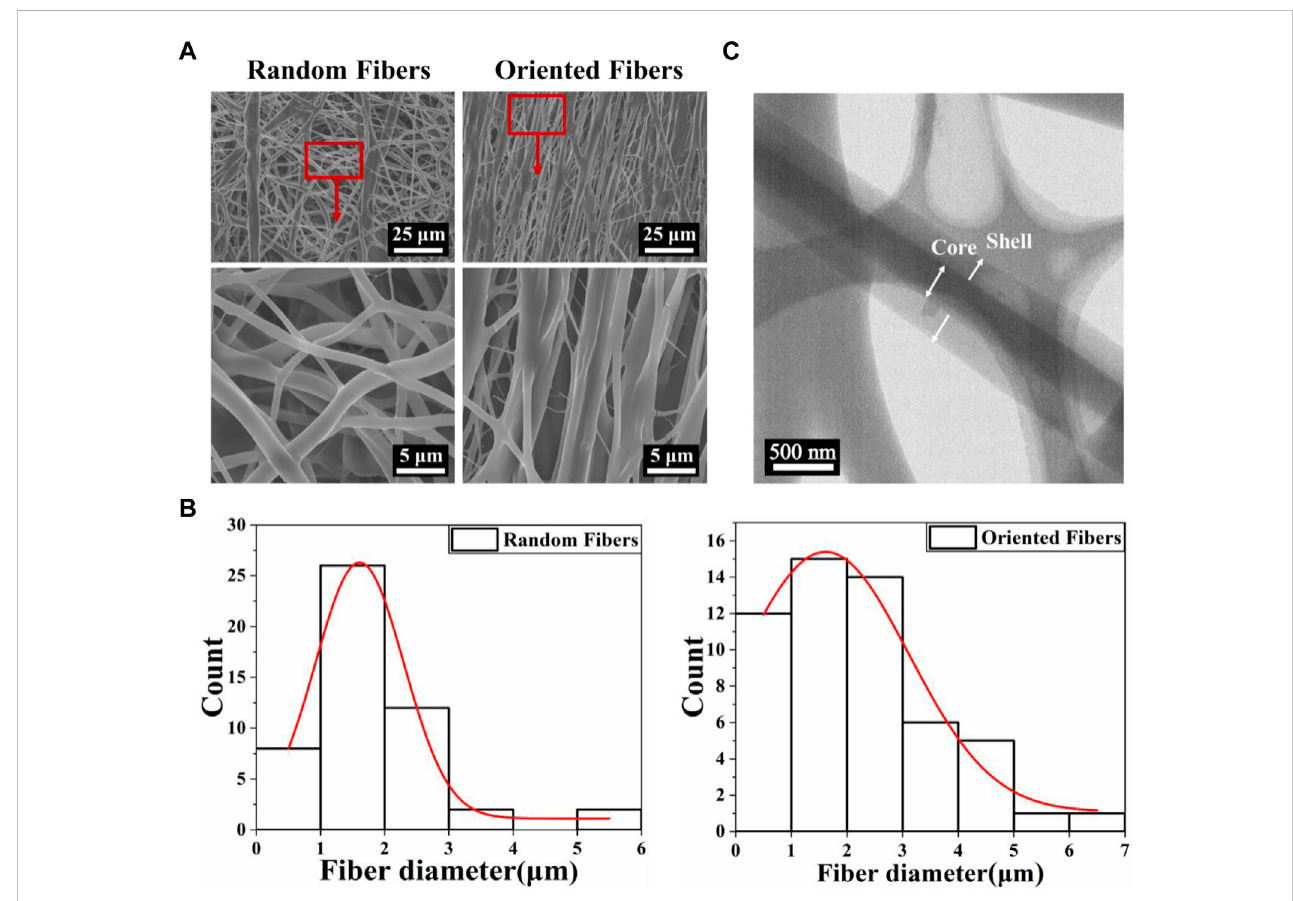
FIGURE 1 Themorphologyanddiameterdistributionof fi berswithacore – shellstructure. (A) Scanningelectronmicroscopyimagesofrandom-andoriented- fi ber